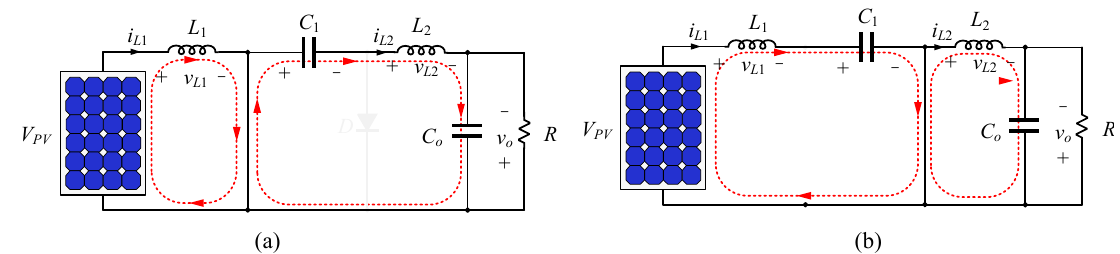
Figure 13. The subintervals in continuous conduction mode. ( a ) is when the active switch is ON; ( b ) is the when the active switch is